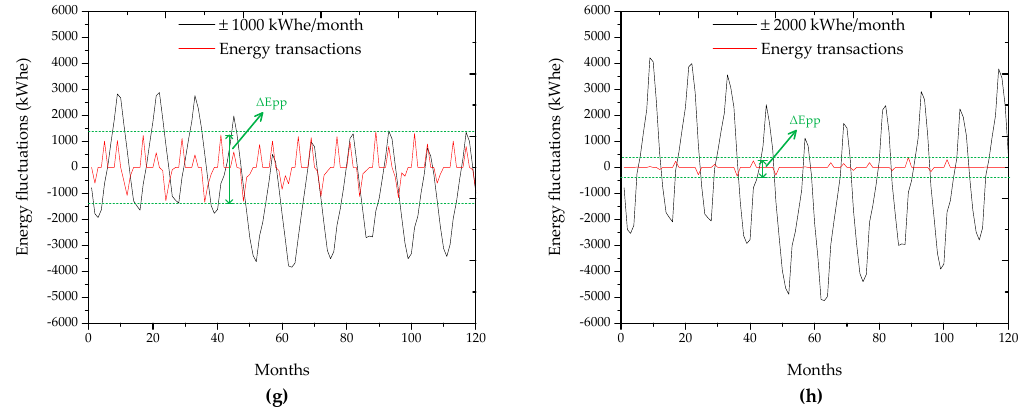
Figure 7. Monthly energy fluctuations in the EESU and energy transactions with the electricity grid for each scenario of EESU maximum permitted storage energy fluctuations. Maximum Permitted EESU Energy Fluctuations Per Month (kWh e / month: ( a ) 0, ( b ) ± 100, ( c ) ± 250, ( d ) ± 400, ( e ) ± 500, ( f ) ± 750, ( g ) ± 1000, ( h ) ± 2000.